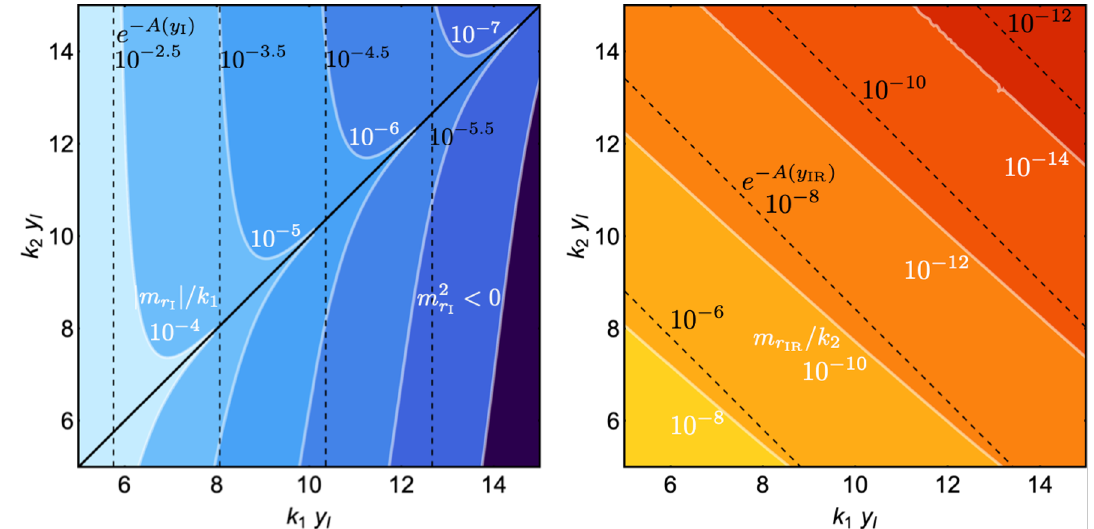
Figure 5 . The heavier (left) and lighter (right) radion masses in the three 3-brane model. Here, we take l = 0 . 3 , u 1 y I = 1 . 5 , u 2 y I = 1 . 5 and y IR /y I = 2 as reference values. In the left panel, the white solid contours denote the heavier radion mass of m r The black dashed lines correspond to the typical mass scale at the intermediate brane of e − k 1 y I = 10 − 2 . 5 , 10 − 3 . 5 , 10 − 4 . 5 , 10 − 5 . 5 from the left to the right, respectively. The solid black line denotes k 1 = k 2 . The radion mass is tachyonic in the region of k 2 < k 1 . Besides, | m r the limit of k 2 → k 1 . In the right panel, the white contours represent the lighter radion mass of m r /k 2 = 10 − 8 , 10 − 10 , 10 − 12 , 10 − 14 from the bottom left to the top right. The black dashed lines IR correspond to the typical mass scale at the IR brane of e − k 2 ( y IR − y I ) − k 1 y I = 10 − 6 , 10 − 8 , 10 − 10 , 10 − 12 from the bottom left to the top